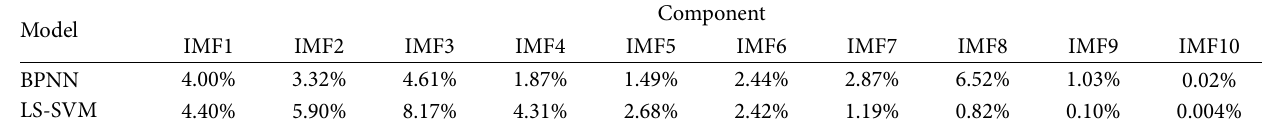
Table 8: The prediction results.